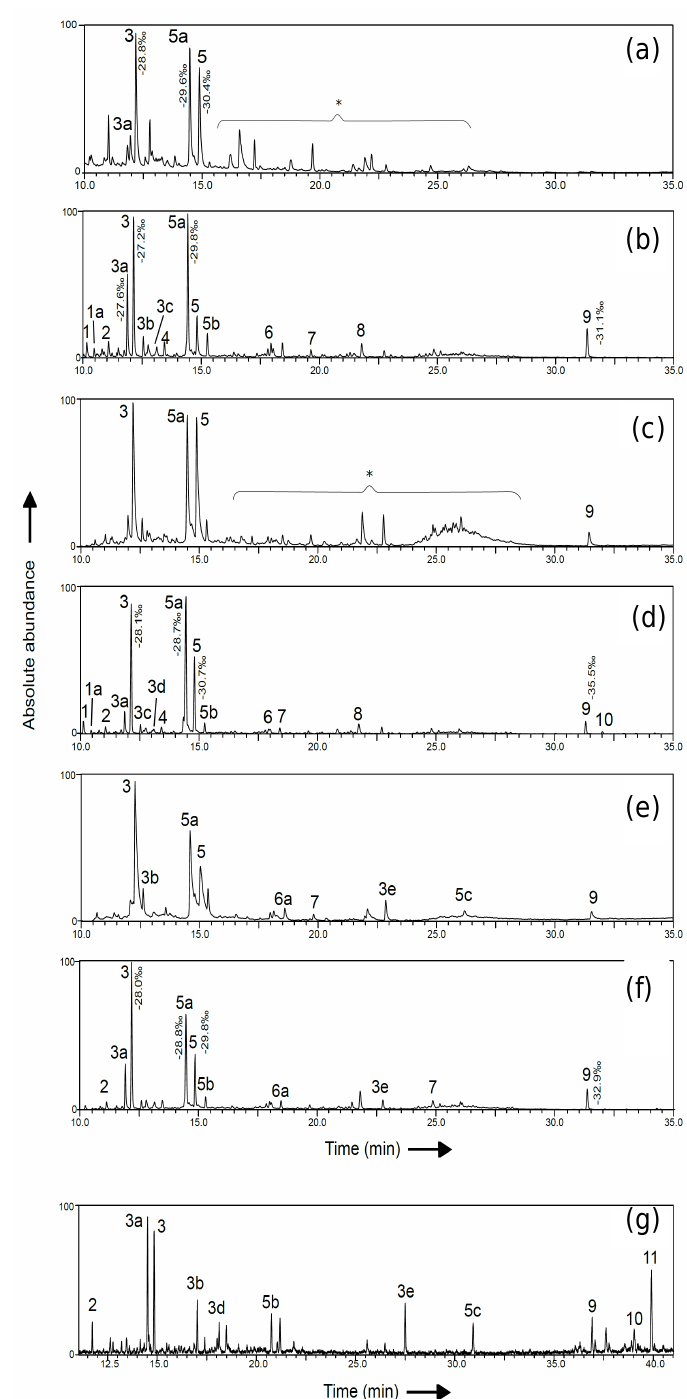
Figure 15. GC/MS chromatogram sections of total lipid extracts of the BIF-type rocks (a–f) . Data are for individual bands excised from the sawn rock in Fig. 7e. Panel (g) illustrates total lipid extract for the modern shallow submarine hydrothermal sediments at Spathi Bay, on the southeast coast of Milos Island. Peak values indicate the lipid-specific δ 13 C values per mil. Because of the low intensity of the lipids recovered, it was not possible to obtain δ 13 C values specific for all peaks. Peaks are annotated as FAME – fatty acid methyl ester; Me – methyl group; TMS – trimethylsilyl; TMSE – trimethylsilyl ester. (1) C 14 : 0 FAME; (1a) C 14 : 0 13Me FAME; (2) C 15 : 0 FAME; (3) C 16 :